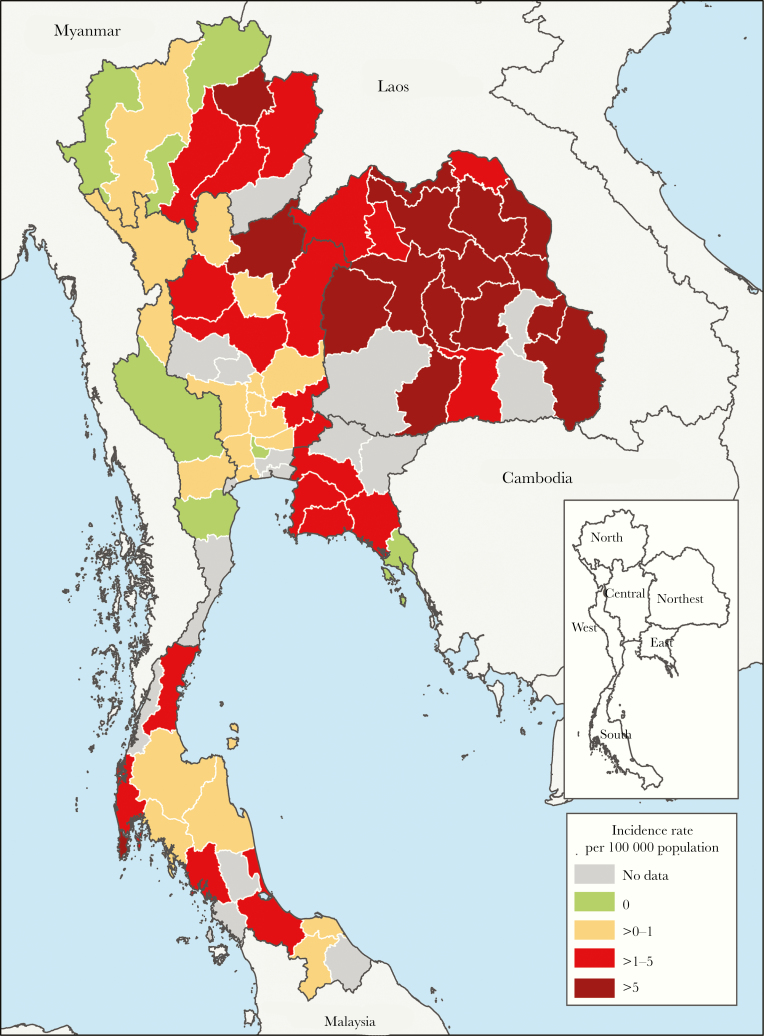
Incidence rates of culture-confirmed melioidosis in Thailand from 2012 to 2015. Provinces are categorized based on incidence rates of culture-confirmed melioidosis observed (dark red, >5 cases per 100 000 population per year; red, >1–5 cases per 100 000 population per year; yellow, >0–1 cases per 100 000 population per year; green, no cases observed; and gray, no data)